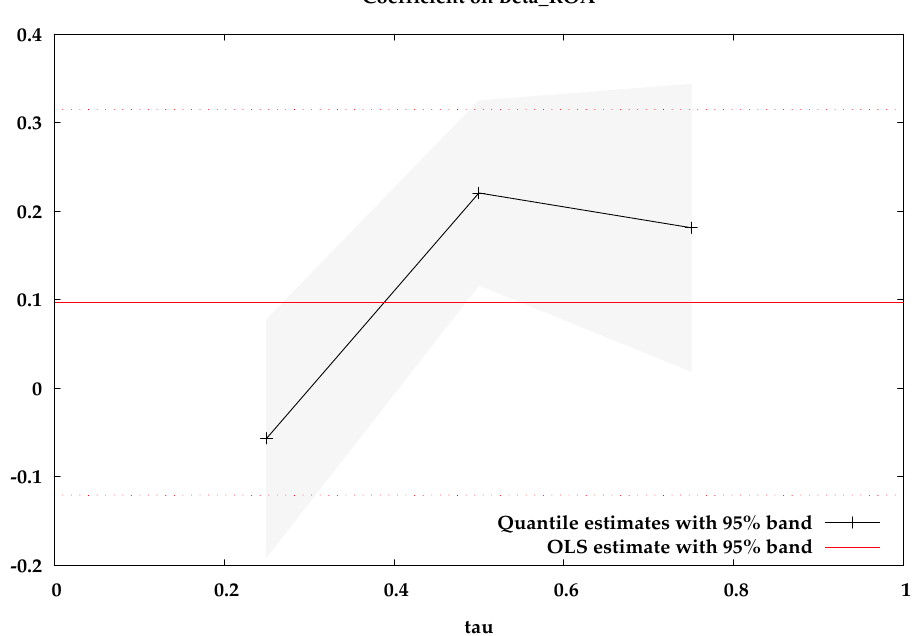
Figure 6. Coefficients across the quantiles with the bootstrapped confidence intervals for regression of beta coefficient vs. beta coefficient for ROA ( τ = 0.25;0.5;0.75, the OLS confidence interval is from − 0.1206 to 0.3153).